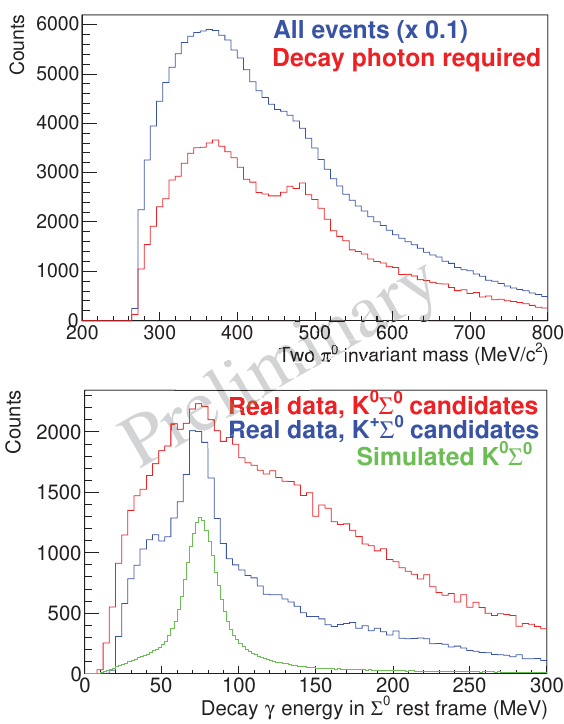
Σ 0 via K 0 → 2 π 0 , S S